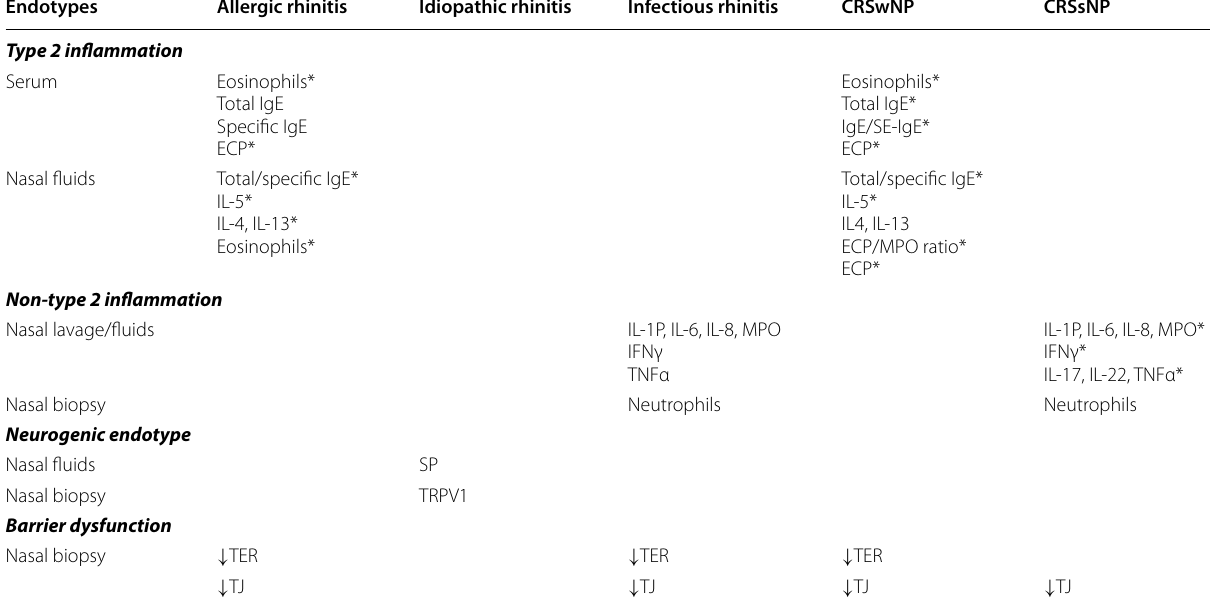
Table 1 Potential diagnostic